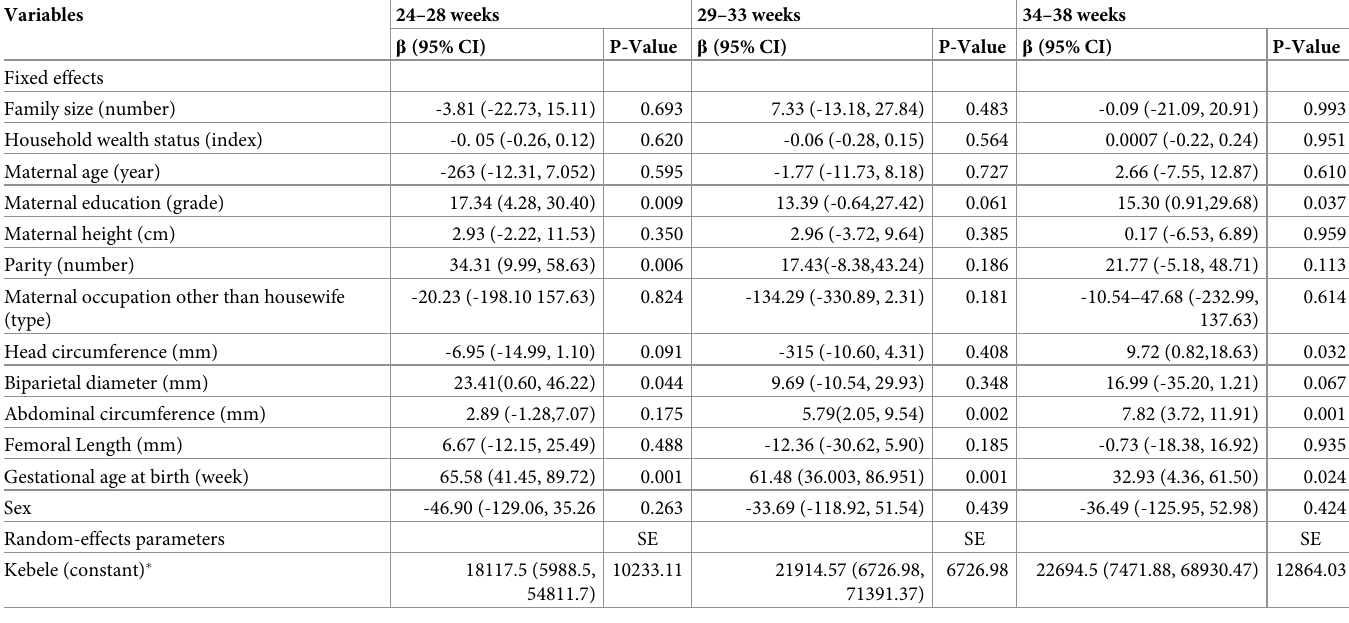
Table 4. Multilevel, mixed-effects regression coefficients for associations of household, maternal, and fetal characteristics with birthweight of children in Adami Tullu district, 2018.